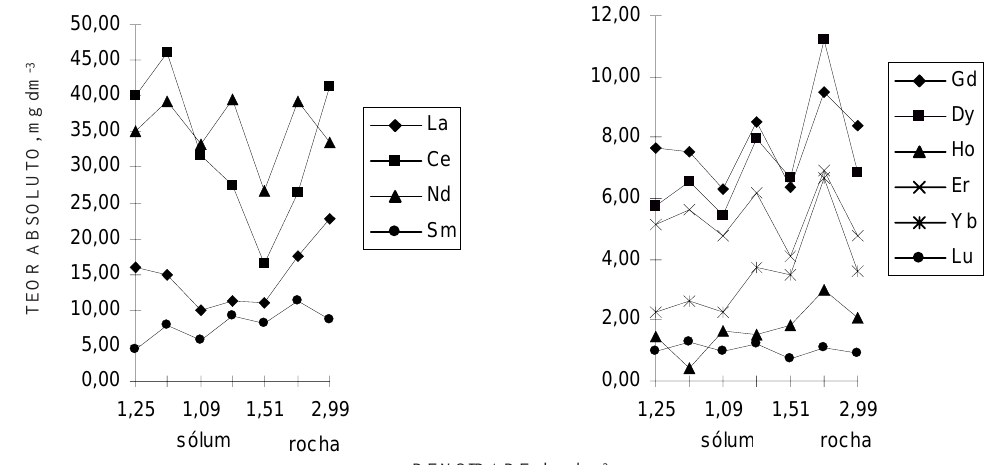
Figura 6. Diagramas de distribuição dos ETR em função da densidade para o perfil 3